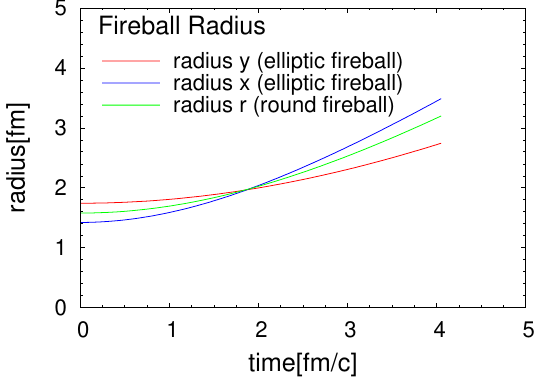
Figure 1 . Transverse radii for the expanding (cid:12)reball in round (green line) and elliptic (red and blue lines) geometry for central p -Pb(5.02 TeV) collisions with a T =0.24 /fm for the round (cid:12)reball, and a x;y =0.34,0.13 /fm for the elliptic